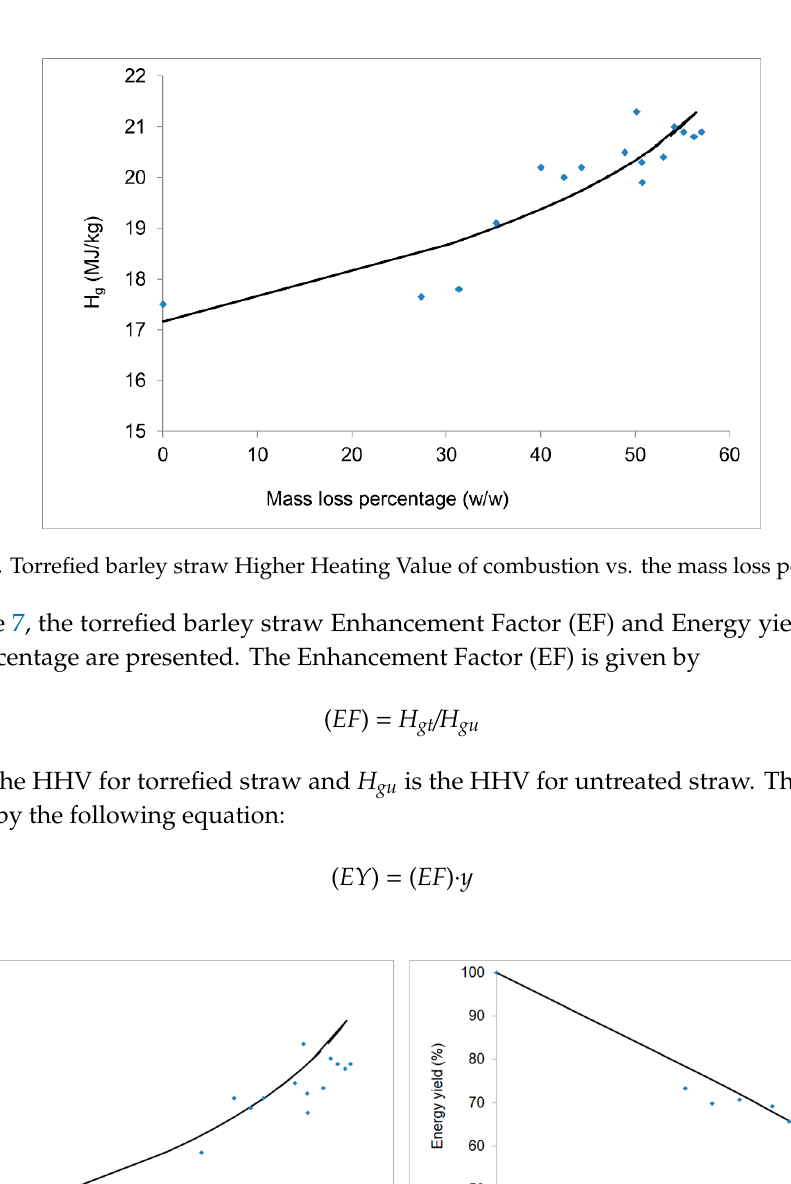
Figure 7. Torrefied barley straw ( a ) Enhancement Factor (EF) and ( b ) Energy yield (EY) vs. the mass loss percentage.